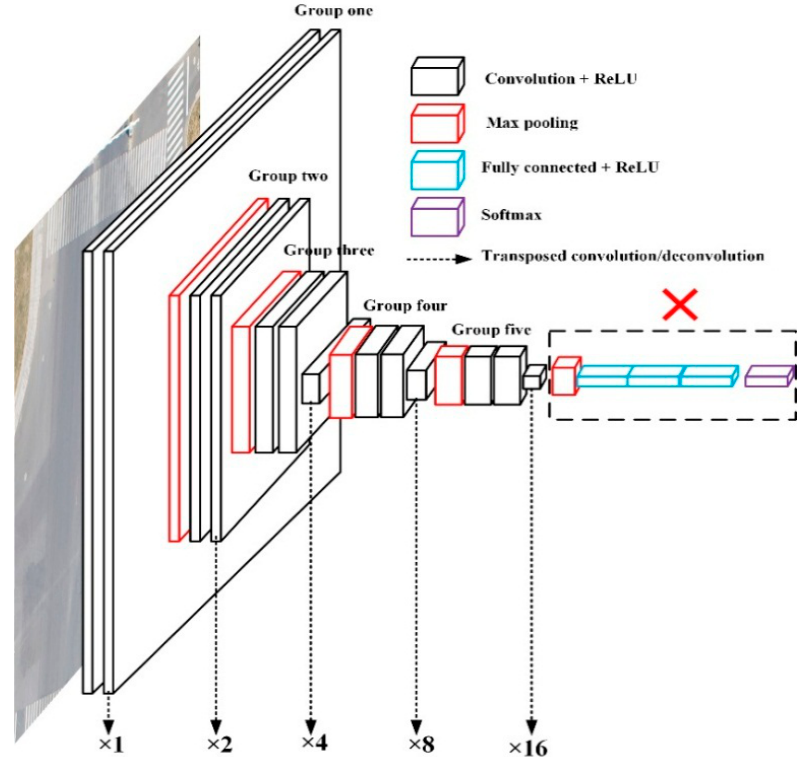
Figure 2. Details of the improved VGG16 architecture.